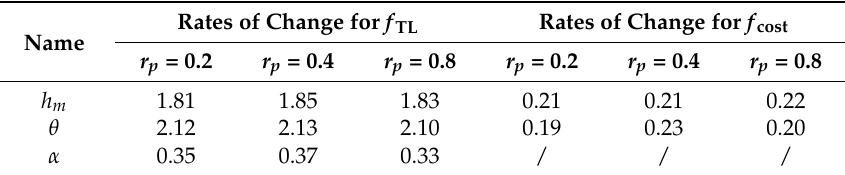
Table 6. Sensitivity analysis of the surface-mounted type of